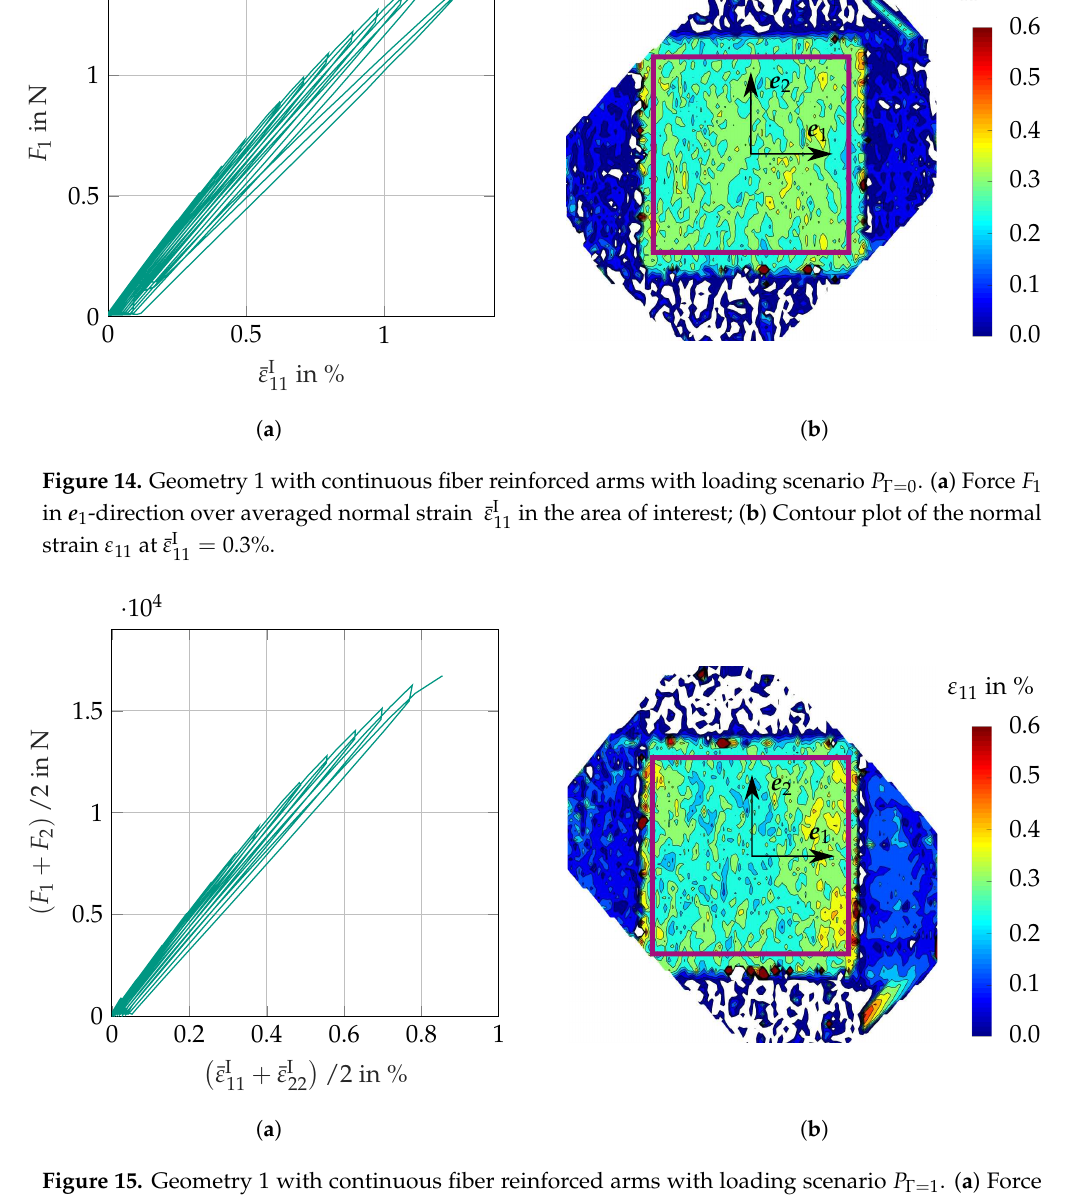
Figure 15. Geometry 1 with continuous fiber reinforced arms with loading scenario P Γ = 1 . ( a ) Force over strain, average values over the e 1 - and the e 2 -direction; ( b ) Contour plot of the normal strain ε 11 = at ¯ ε I 11